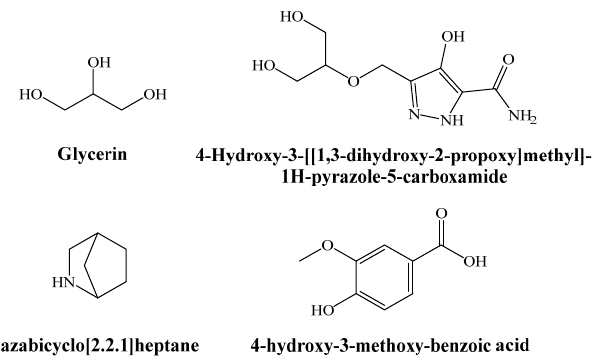
Figure 1. Main phytochemicals identified in the aqueous ammonia extract of Quercus suber bark.